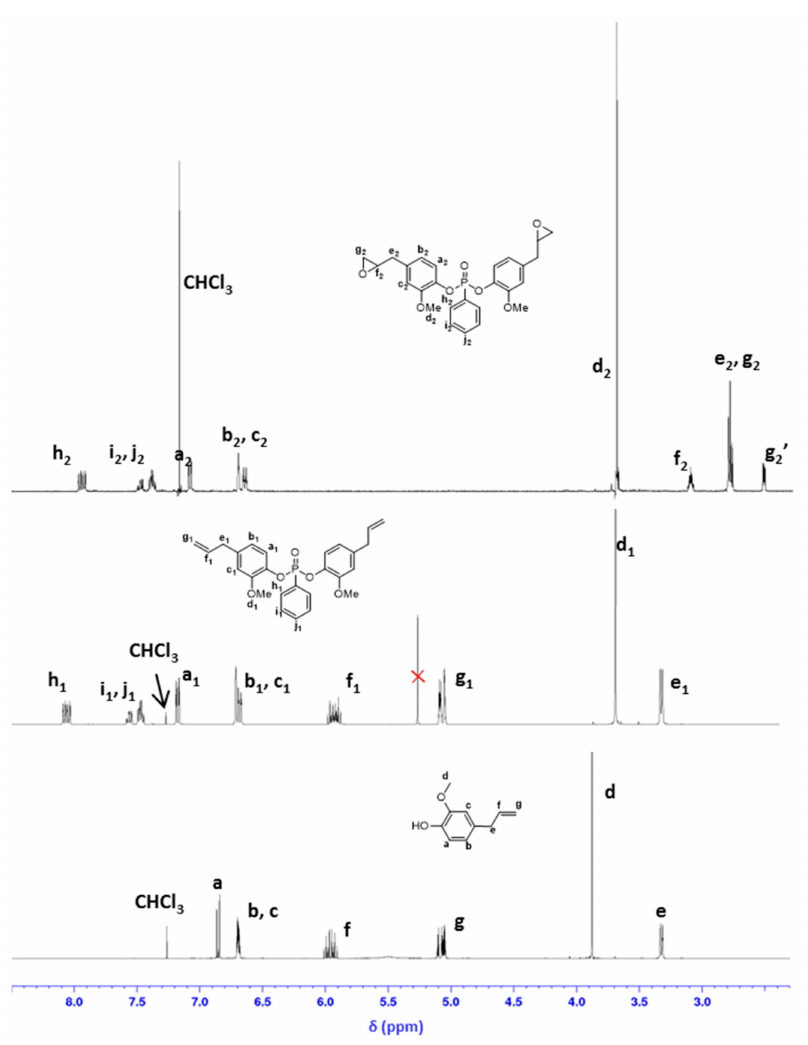
Figure 2. Stacked 1 H NMR spectra of: Eugenol (bottom), DEP-Ph (middle) and DEEP-Ph (top) in CDCl 3